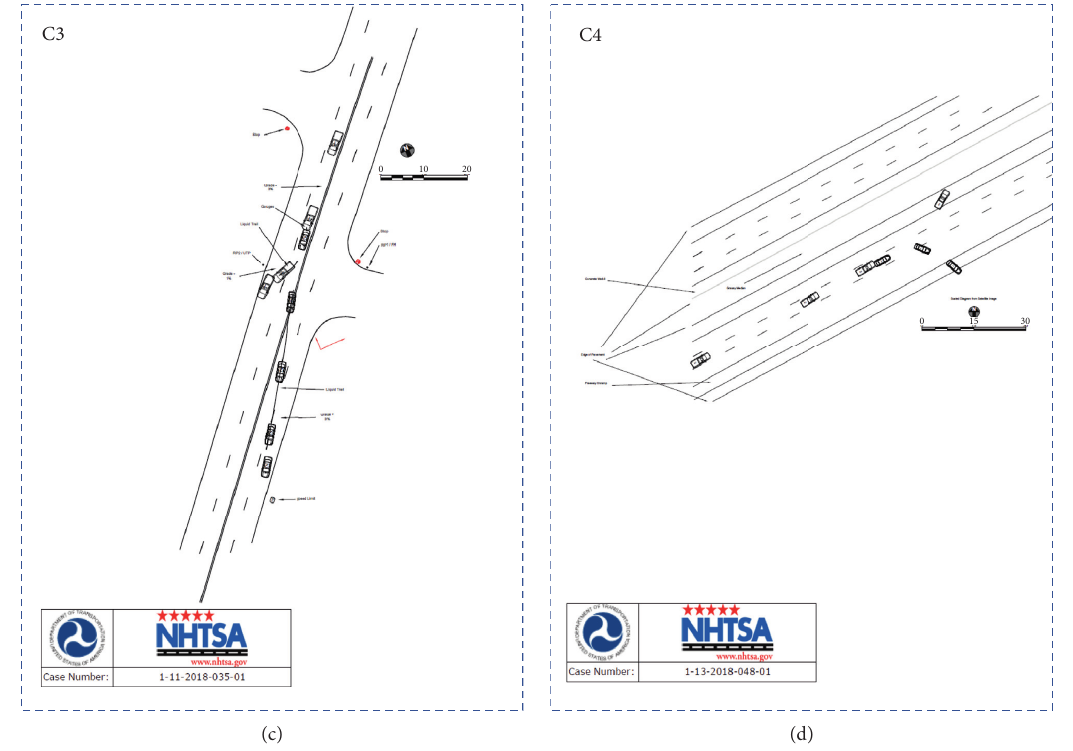
Figure 17: Crash scene diagram for each scenario. (a) C1. (b) C2. (c) C3. (d) C4.